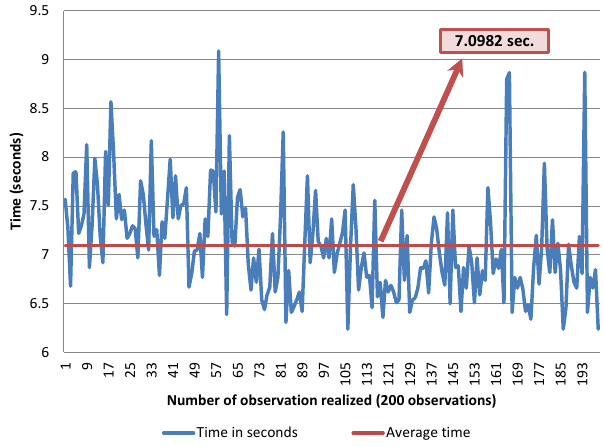
Figure 8. Average time with the thick wheel model.